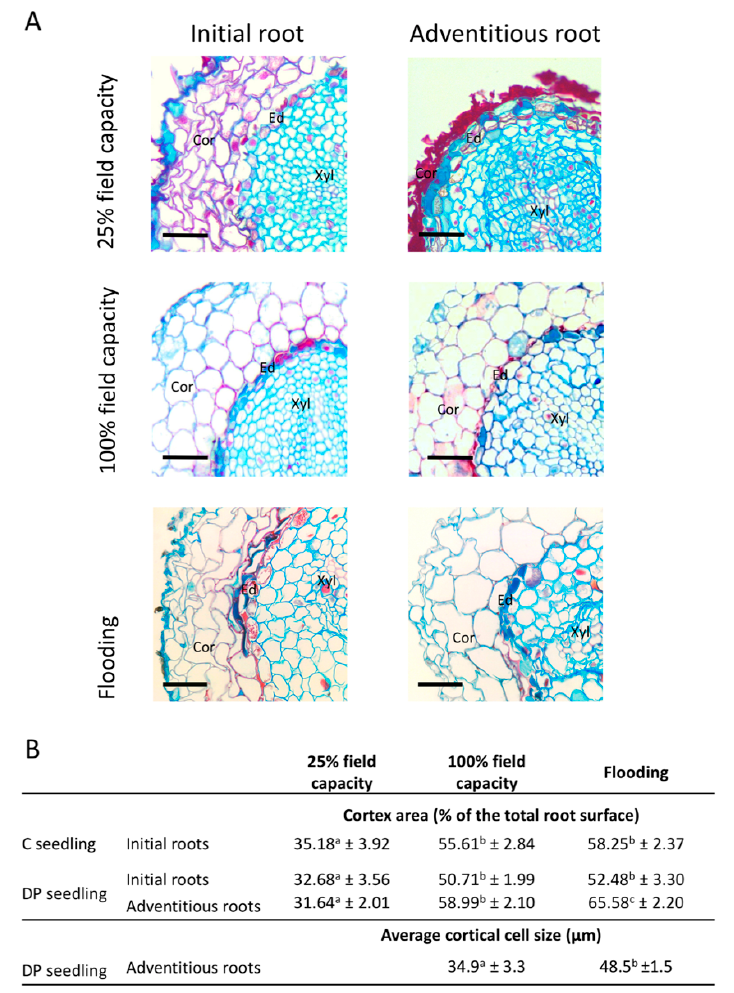
Figure 6. Initial and adventitious root morphology of black spruce seedlings under different irrigation regimes. ( A ) Cross-section of initial and adventitious roots of seedlings irrigated at 25% field capacity, 100% field capacity, or flooded. Sections were taken at 20–40 mm from the root tip (Bars = 50 μ m; Ed, Endodermis; Cor, Cortex; Xyl, Xylem). ( B ) Significant measurements of cortex area and average cortical cell size of initial and adventitious roots of seedlings irrigated at 25% field capacity, 100% field capacity, or flooded, according their stock types. Values are grand median ± SE. Different letters in the same row indicate significant differences at P ≤ 0.05.